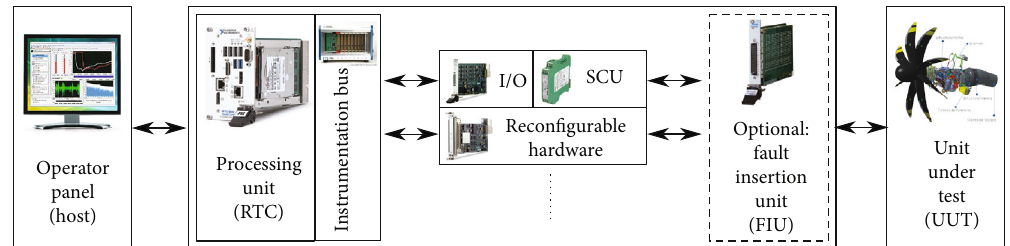
Figure 9: Veri fi cation equipment with recon fi gurable